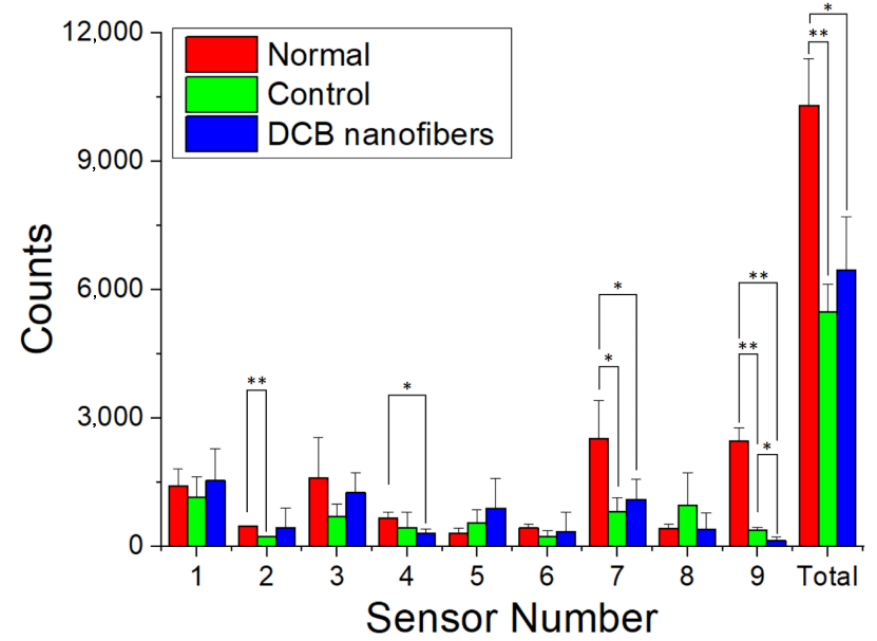
Figure 7. Bioactivity counts of the rats in various groups (* p < 0.05, ** p < 0.01).